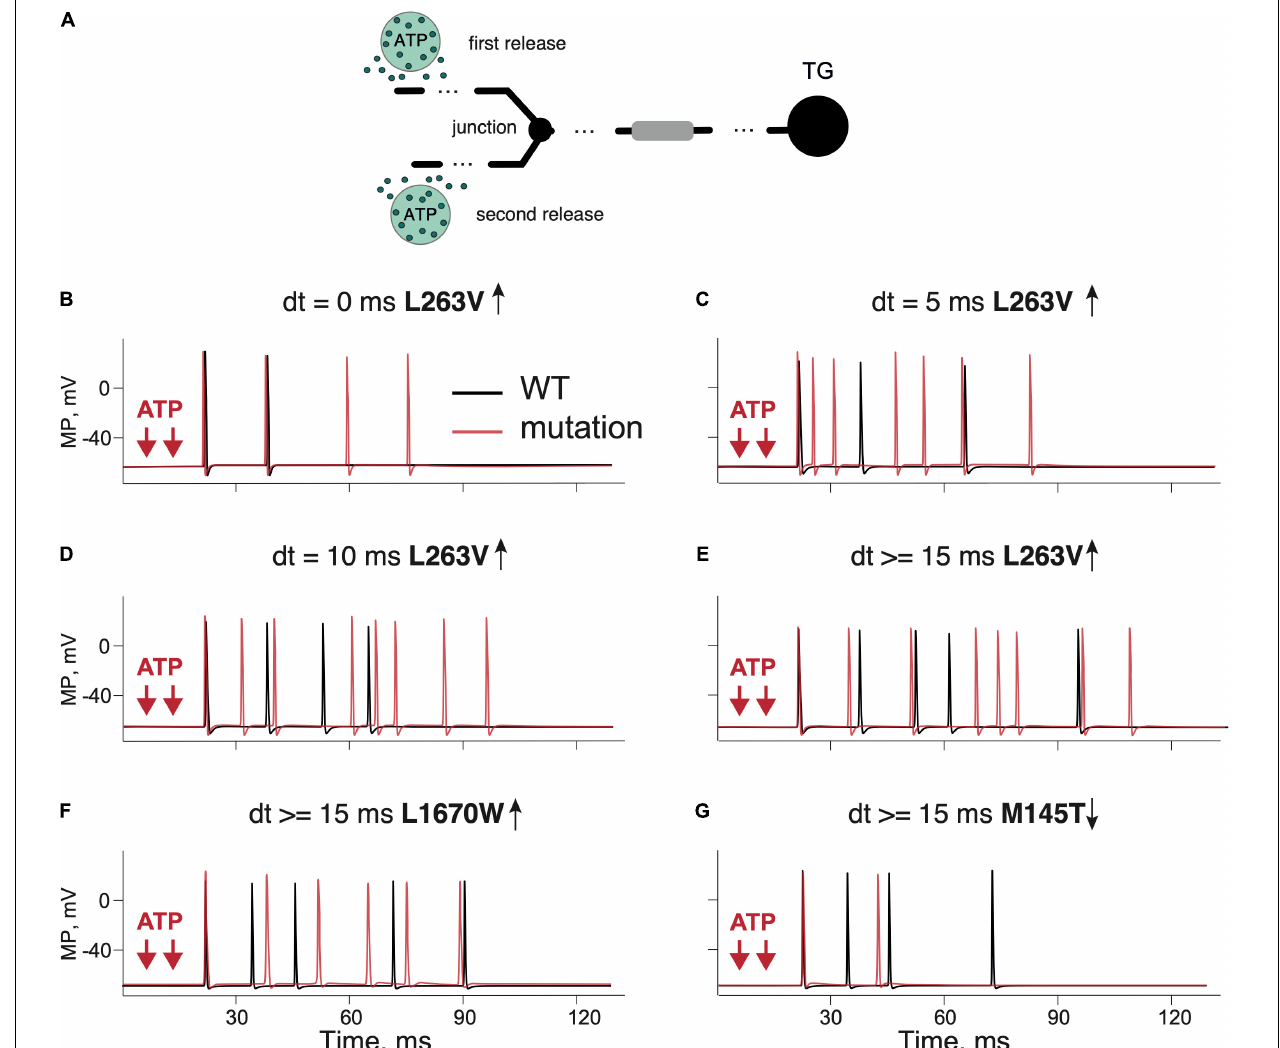
FIGURE 4 | Testing the role of branching and multiple ATP release events in firing of the WT and mutant A δ -fibers. (A) Schematic presentation of a dendritic tree with two branches and two ATP release events. (B) Firing activity of the L263V Na V 1.1 mutant (red line) and WT (Kahlig et al., 2008) fiber (black line) with simultaneous ATP release events. (C) The L263V mutant (red line) and WT (Kahlig et al., 2008) fiber (black line) with ATP release with an interval of 5 ms. (D) The L263V mutant (red line) and WT (Kahlig et al., 2008) fiber (black line) with an 10-ms interval. (E) The L263V mutant (red line) and WT (Kahlig et al., 2008) fiber (black line) with an 15-ms interval. (F) The L1670W (red line) and WT (Dhifallah et al., 2018) fiber (black line) with an interval of 15 ms. (G) Firing in the loss-of-function mutant M145T (red line) and WT (Mantegazza et al., 2005) fiber (black line) with an ATP release interval of 15 ms. Note that branching and multiple ATP release increased the firing in the case of a gain-of function but reduced in the case of a loss-of-function. ATP signaling is limited by partial